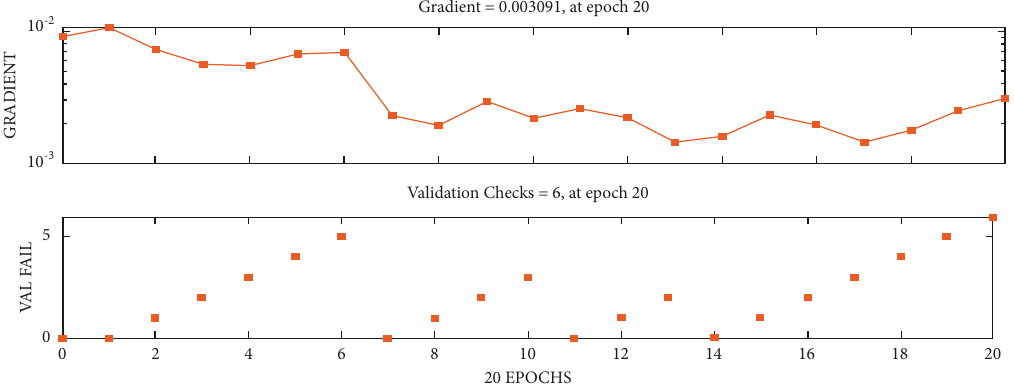
Figure 6: Training state for healthy-healthy